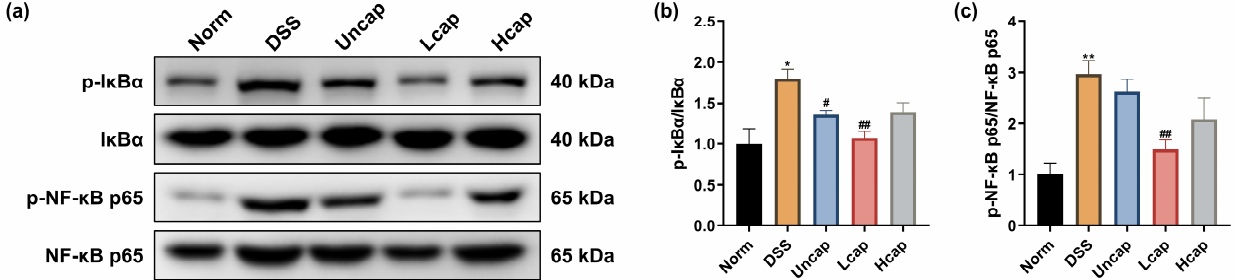
Figure 5. S. spongiosa polysaccharides modulate the NF- κ B pathway in colitis mice. ( a ) The protein abundances of p-I κ B α , I κ B α , p-NF- κ B p65 and NF- κ B p65 were estimated by Western blotting analysis. ( b ) The normalization of p-I κ B α to I κ B α . ( c ) The normalization of p-NF- κ B p65 to NF- κ B p65. The values are reported as means ± SD ( n = 8). * p < 0.05 and ** p < 0.01 vs. Norm group; # p < 0.05 and ## p < 0.01 vs. DSS group.